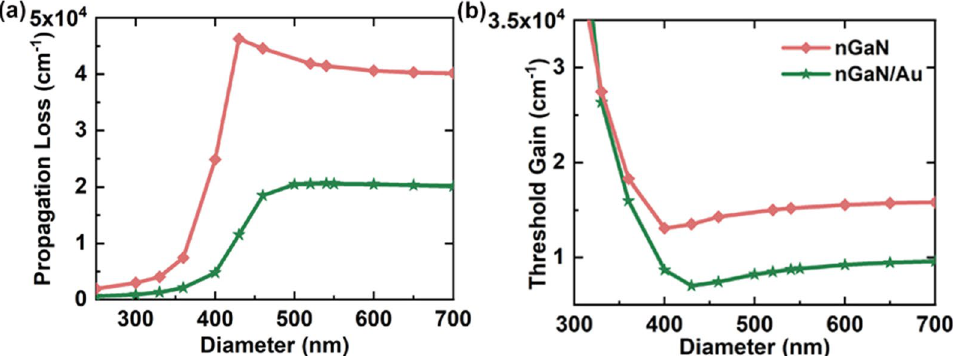
Fig. 7 Propagation loss a and threshold gain b versus NW diameter for the plasmonic laser on nGaN (red lines) and nGaN/Au (green lines)